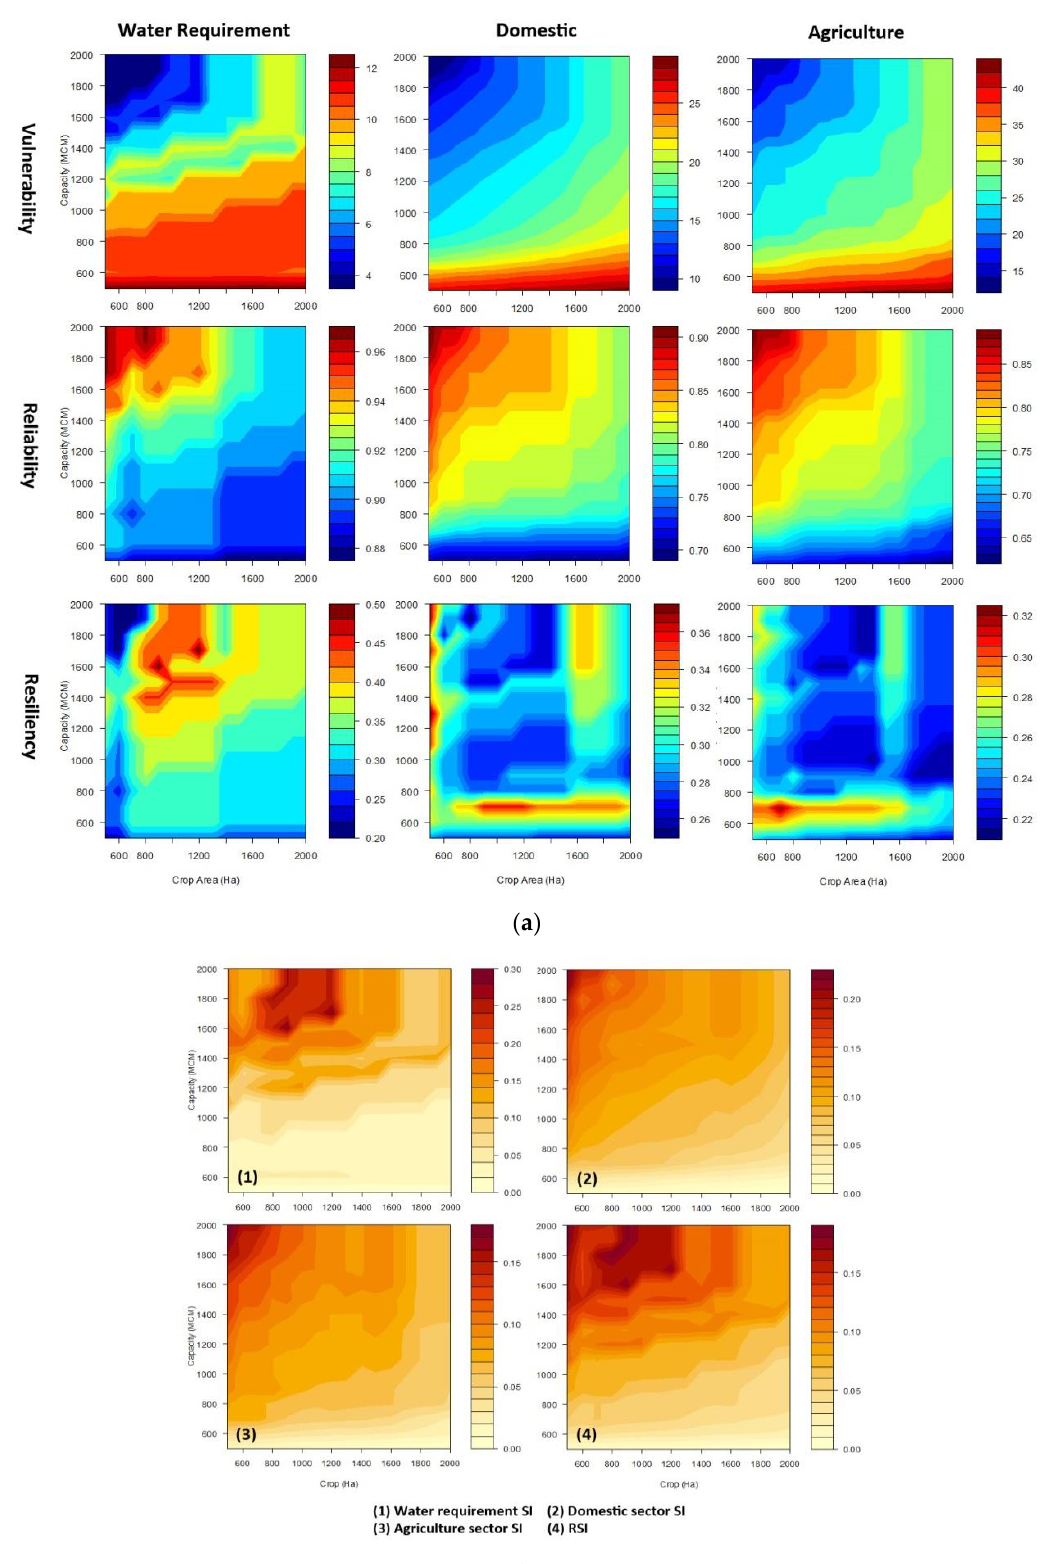
Figure 7. RRV and sustainability index-capacity-irrigated area relationships for Bukan reservoir. ( a ) RRV measures ( b ) 1 to 3 show sustainability indices (RS) for water requirement, domestic, and agricultural water use, respectivelym and 4 denotes the relative sustainability index (RSI).